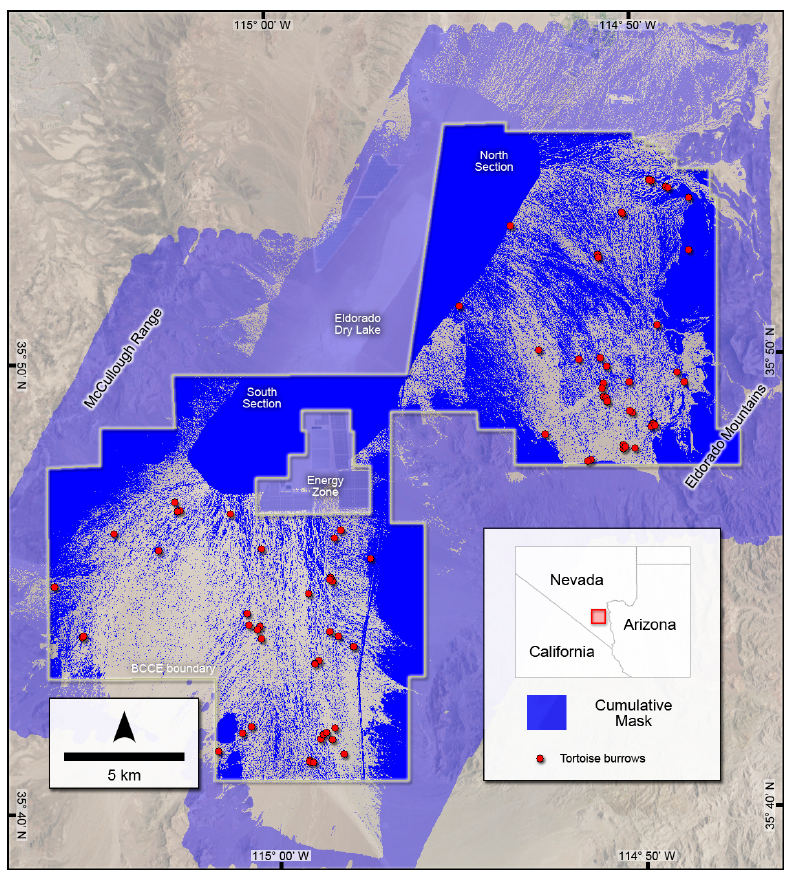
Figure 8. Map showing a cumulative overlay of all five criteria, each shown in blue. Areas without color (grey is the background imagery) have met all the criteria. The BCCE is shown as a gray outline, and red dots indicate locations with visual confirmation of tortoise burrows.